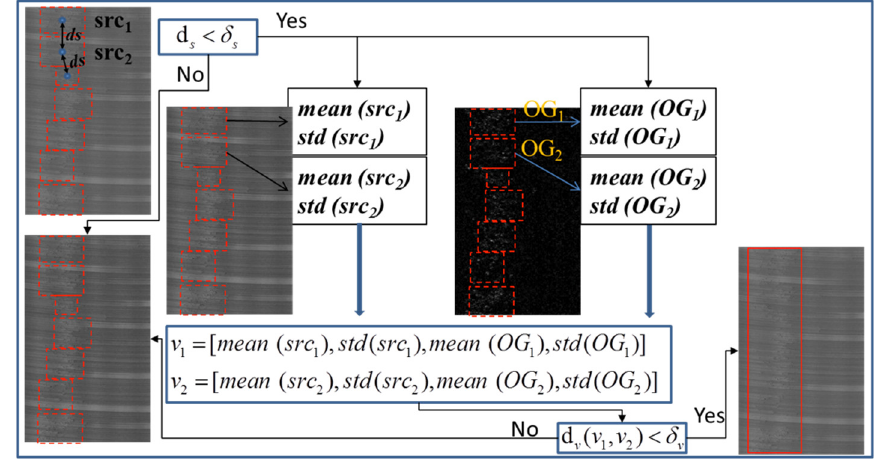
gradient images. ( b )